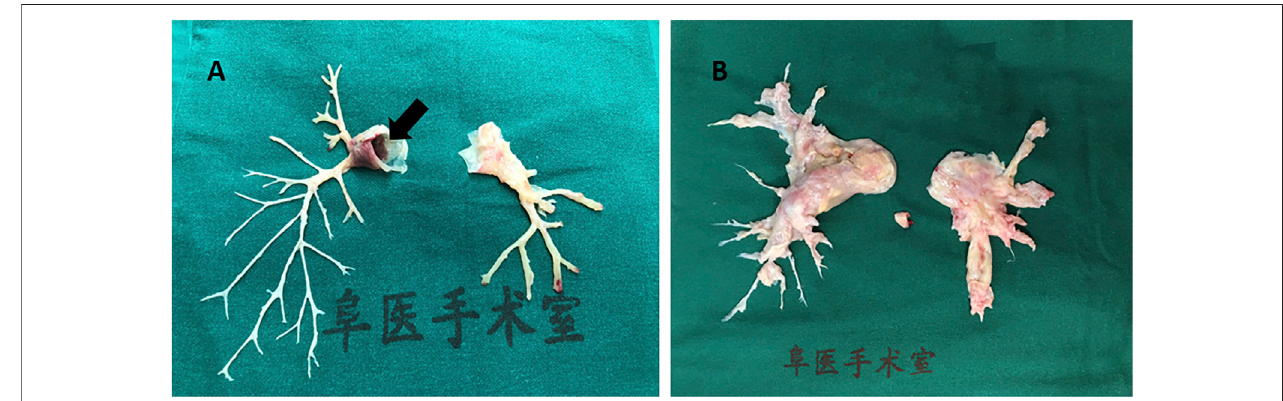
FIGURE 1 | Human pulmonary artery pathological specimen shows (A) in fl ammatory intima specimen accompanied with emboli in pulmonary artery main trunk (black arrow) taken from a patient of pulmonary vasculitis; (B) hyperplasia endothelial tissue from pulmonary endarterectomy operation in chronic thrombosis embolic pulmonary hypertension (CTEPH)